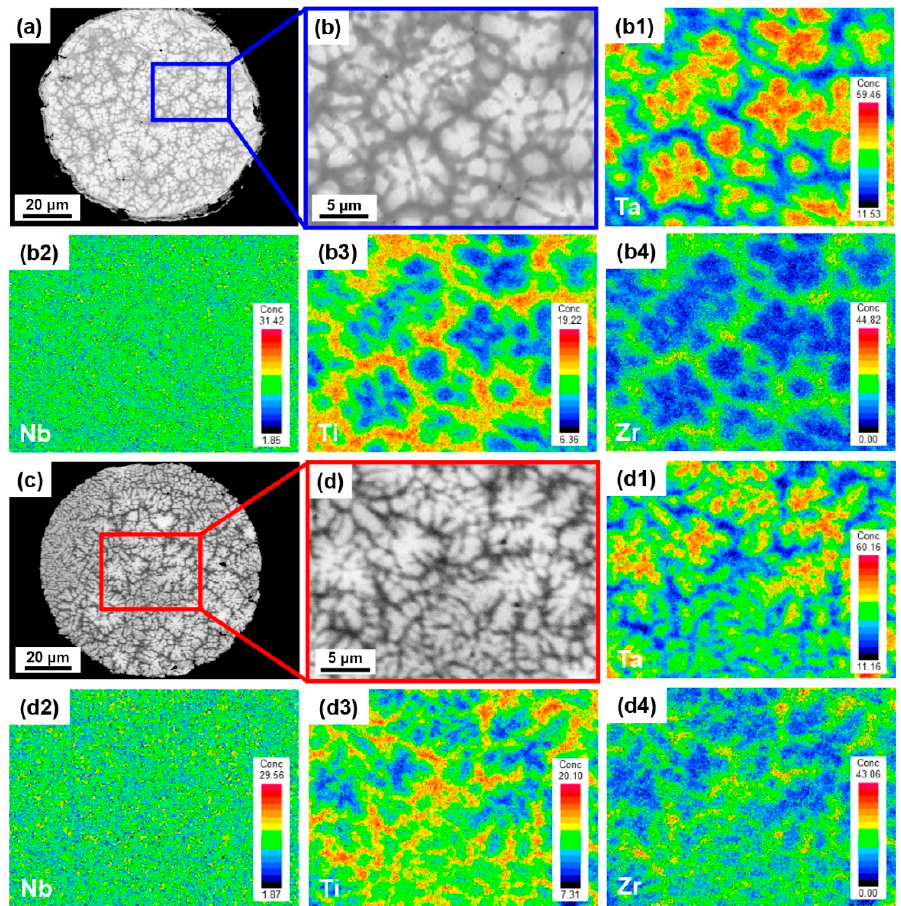
Figure 8. SEM images of the ( a , b ) EIGAed and ( c , d ) PREPed TaNbTiZr RHEA powders; ( b1 – b4 ) and ( d1 – d4 ) are the elemental mapping of the marked regions in ( a ) and ( c ), respectively.